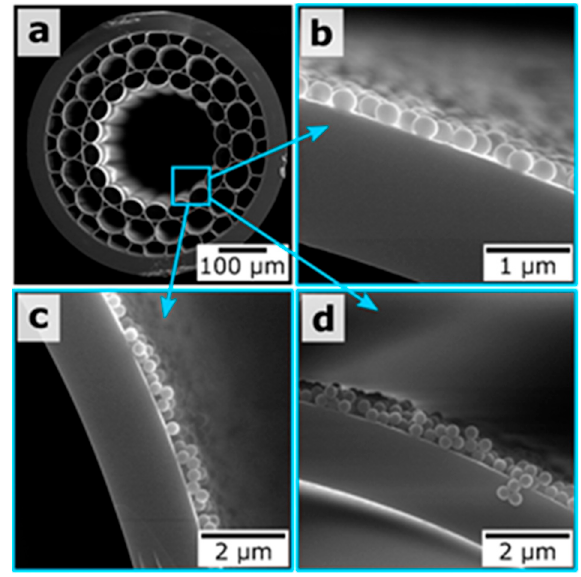
Figure 13. ( a ) SEM image of the MOF end face. ( b – d ) Magnified SEM images of the hollow-core regions for the MOF samples coated with one, two, and three layers of 300 nm silica particles, respectively. Reproduced with permission from